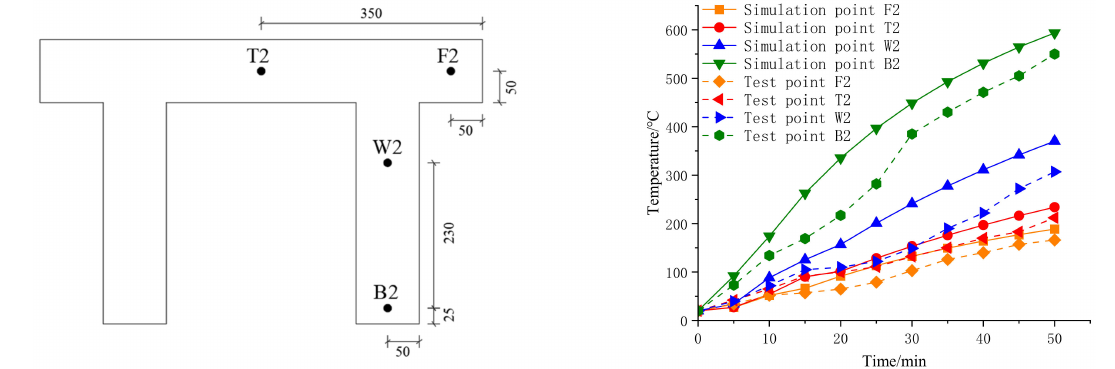
Figure 5. Temperature rise curves of measurement